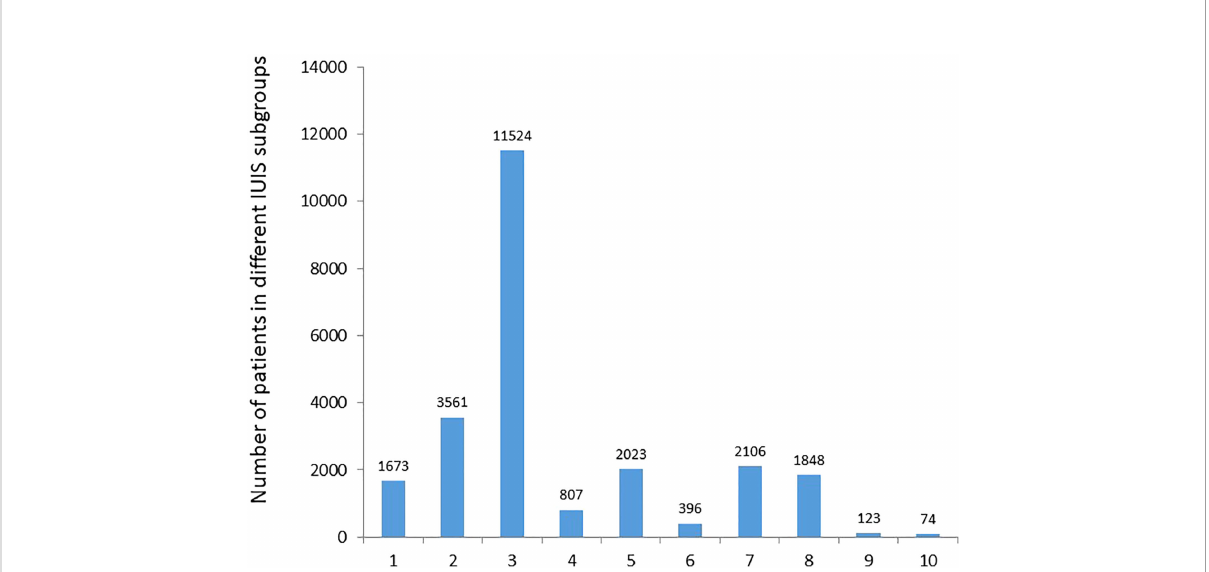
FIGURE 3 The total number of patients reported from 30 countries to various IUIS subgroups. The most common subgroups were predominantly antibody de fi ciency (11510) and combined immunode fi ciencies with associated or syndromic feature (3557). The number of patients with periodic fever syndrome does not include patients reported from Armenia (3151 pts) to avoid unproportional presentation (see Table 1). The number of patients with no de fi nitive IEI diagnosis was 734 representing 2,95% of the total number of 24,862